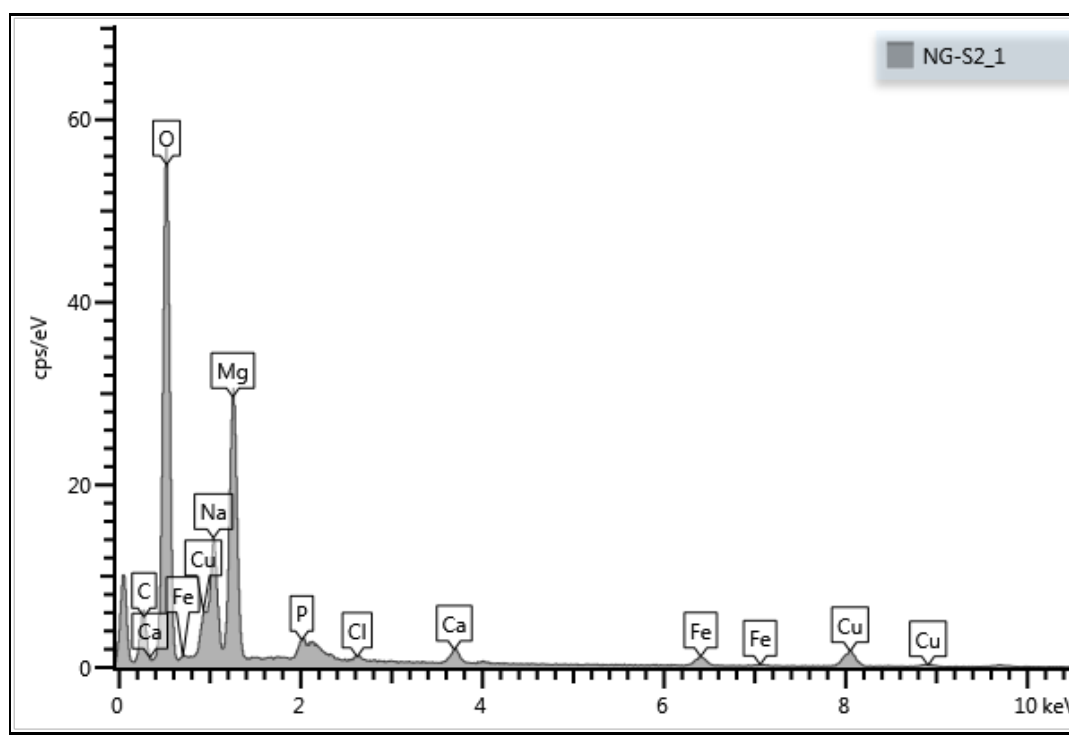
Appl. Nano 2023 , 4 , FOR PEER REVIEW Figure 4. SEM-EDX analysis of Fe/Cu bimetallic nanoparticles. Figure 4. SEM-EDX analysis of Fe/Cu bimetallic nanoparticles.